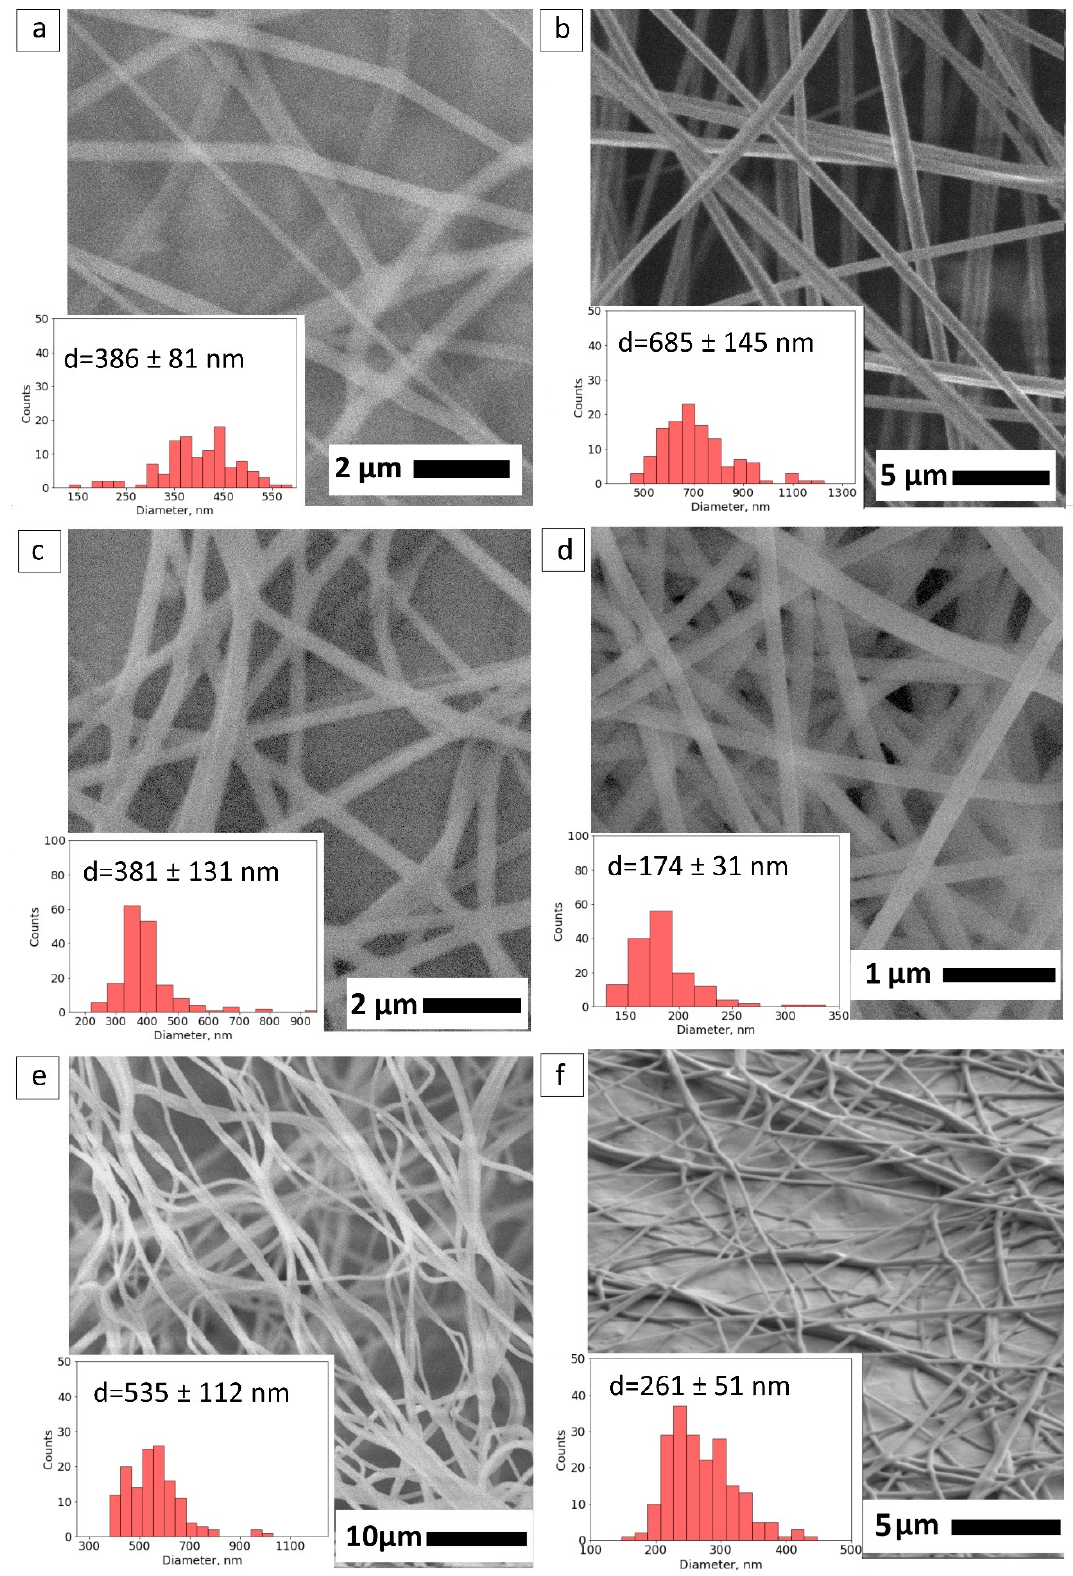
Figure 2. SEM imaging of fibers: ( a ) pristine PVA; ( b ) PVA-PEG core; ( c ) PVA–PEG–SiO 2 core; ( d ) shell PVA–GO 10%; ( e ) core-shell PVA-PEG@PVA–GO); and ( f ) core-shell PVA–PEG–SiO 2 @PVA–GO.